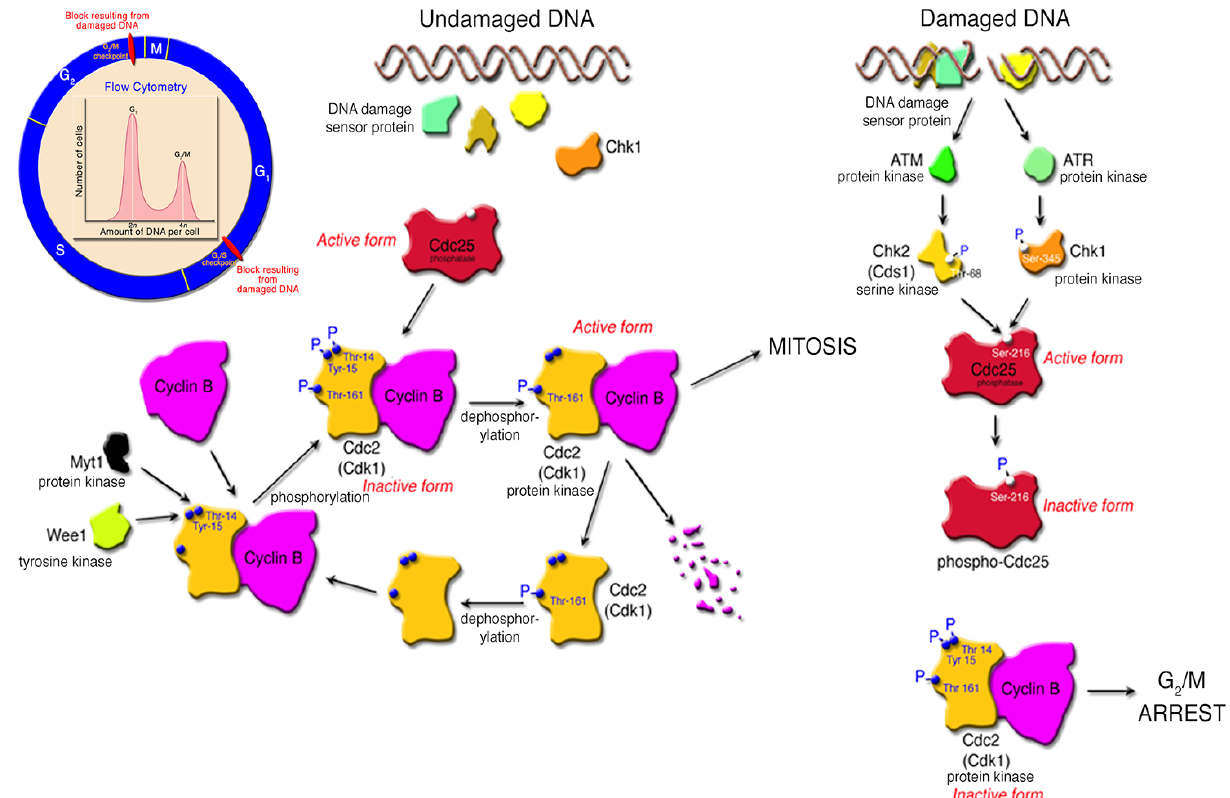
Figure 3. Checkpoint pathway, in response to DNA damage, that leads to growth arrest at /M interphase of the cell cycle in epithelioid cells. The inset illustrates the standard the G 2 DNA damage checkpoints at G /S and G /M in the cell cycle. Cell cycle arrest at G 1 2 be measured by flow cytometry or cell sorting. Populations that are arrested at G accumulate cells that have a 4 n DNA